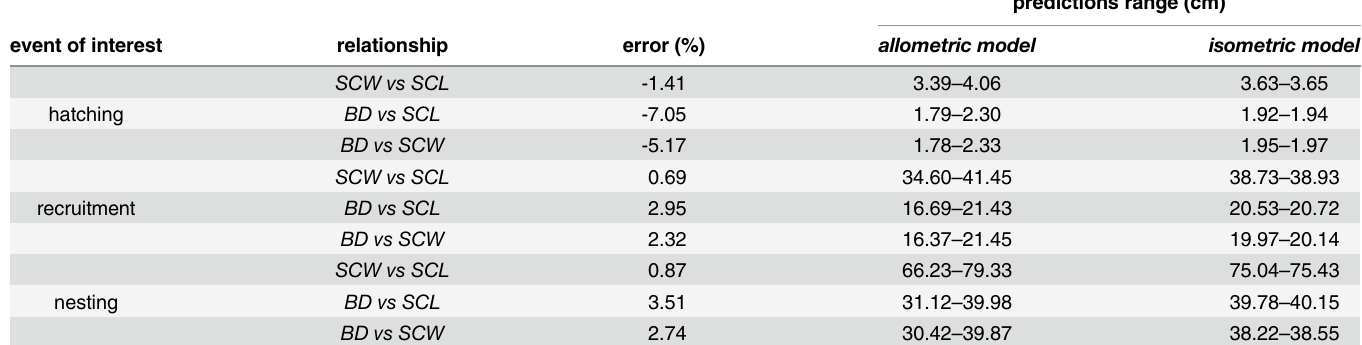
Table 6. Comparison of the allometric model (value of b regressed by model fitting) to the isometric model ( b = 1). As the allometric model we used the predictive regression equation ‘ m I + II + III ’ . As size at the event of interest, we used average values at hatching SCL = 4.5 cm [33], recruitment SCL = 48 cm [9], and nesting SCL = 93 cm [28, 31] for the relationships of carapace width and body depth to carapace length. For the relationship of body depth to cara- pace width we calculated SCW values that would correspond to average carapace lengths at hatching, recruitment, and nesting, using ‘ m I + II + III ’ . Error was calculated for log e transformed data as [100(value predicted by isometric model — value predicted by allometric model)/ value predicted by allometric model].